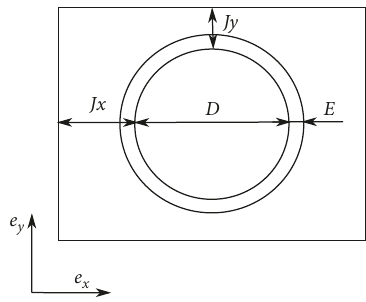
Figure 3: Confinement geometry at midplane L obstacle.